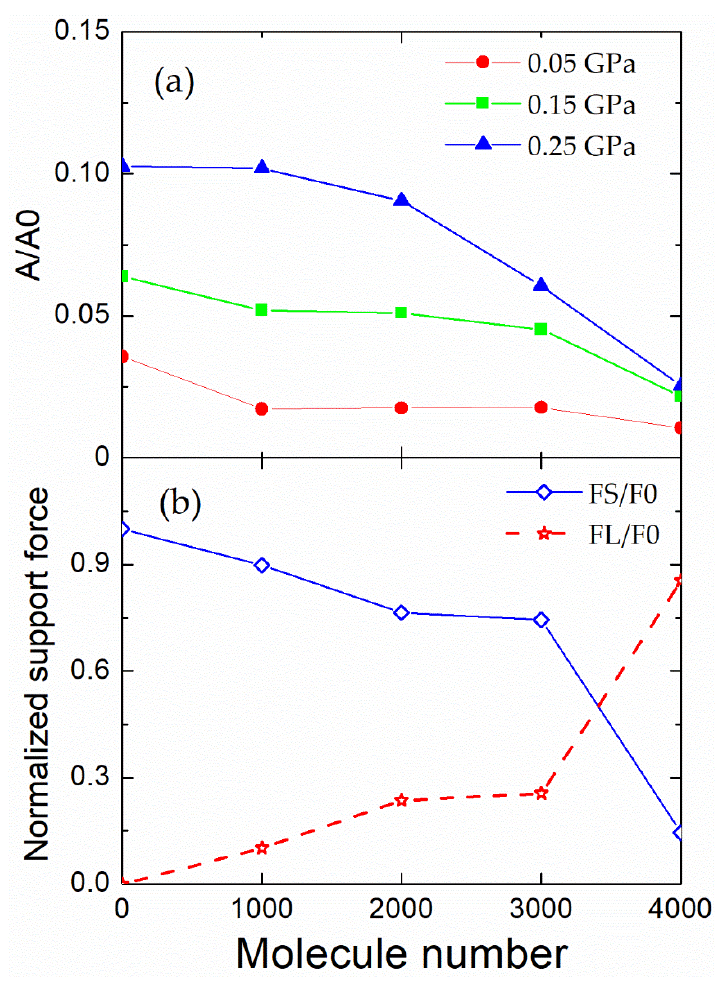
Figure 6. Contact area ( a ) and the normalized normal force ( b ) as a function of the lubricant molecule number for surface with a roughness RMS = 0.8 nm. The molecule number of zero indicates dry contact. The load is 0.25 GPa in (b).